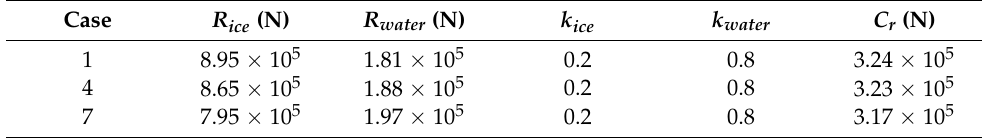
Figure 12. Calm-water resistance of Case 1, Case 4 and Case 7. Table 9. C r of the polar ship navigating in a combined route. Table 9. C r of the polar ship navigating in a combined